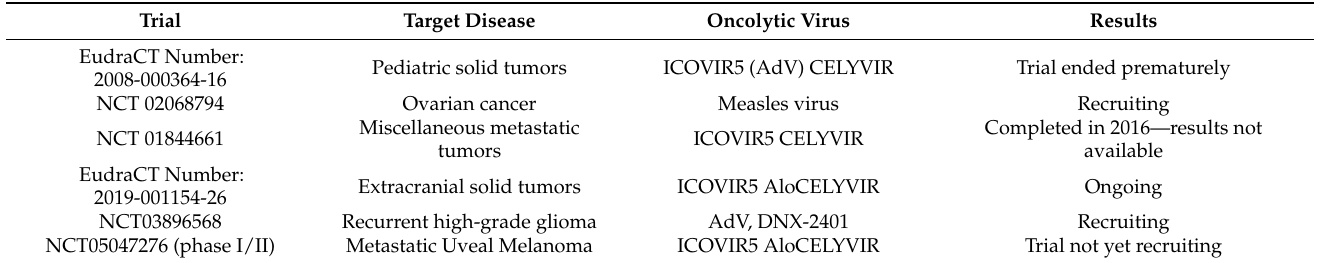
Table 1. Clinical trials involving mesenchymal stem cells (MSCs) as carriers for oncolytic viruses (as of December 2021). Abbreviations: AdV Adenovirus. CELYVIR: bone marrow-derived autologous MSCs infected with ICOVIR5 (oncolytic AdV). AloCELYVIR: bone marrow-derived allogeneic MSCs infected with ICOVIR5 (oncolytic